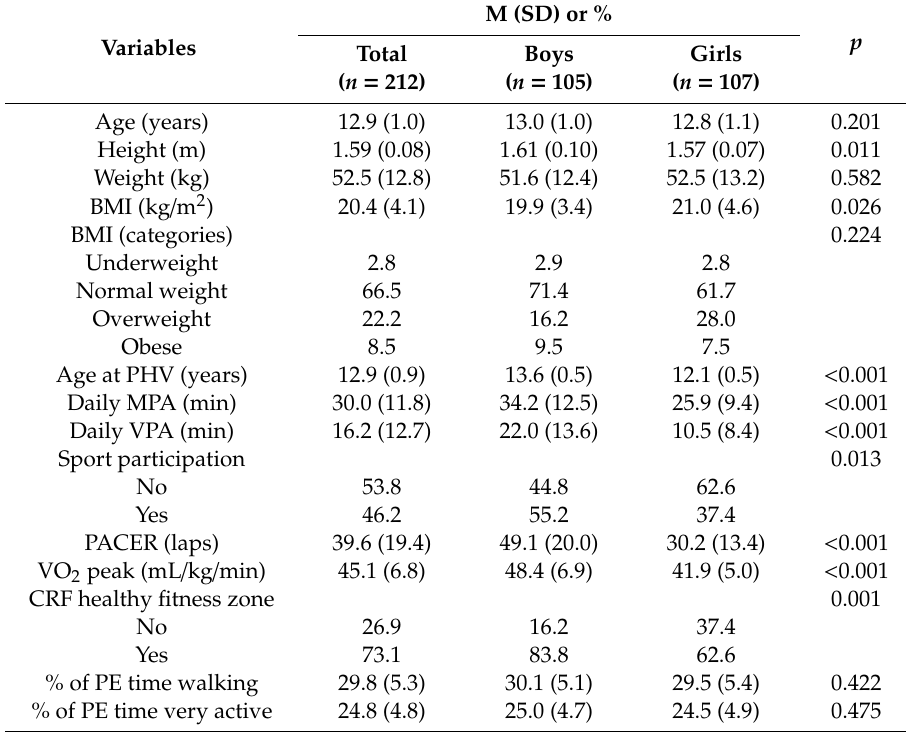
Table 1. Sample baseline